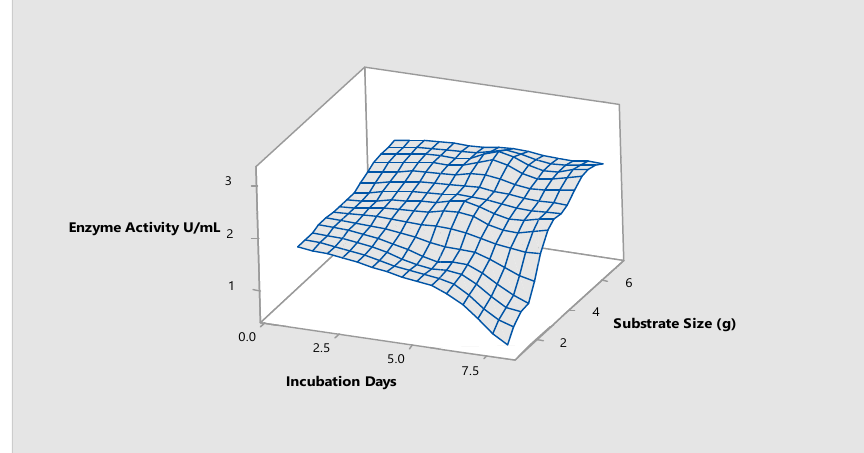
Figure 7. Surface plot of Enzyme Activity (U/mL) vs. Substrate Size and Incubation Days.